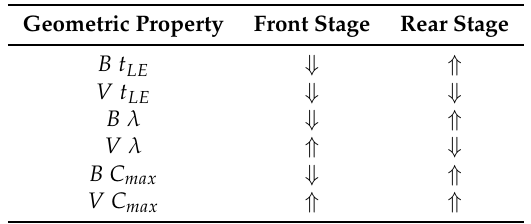
Table 1. Direction of geometric properties for maximum η is